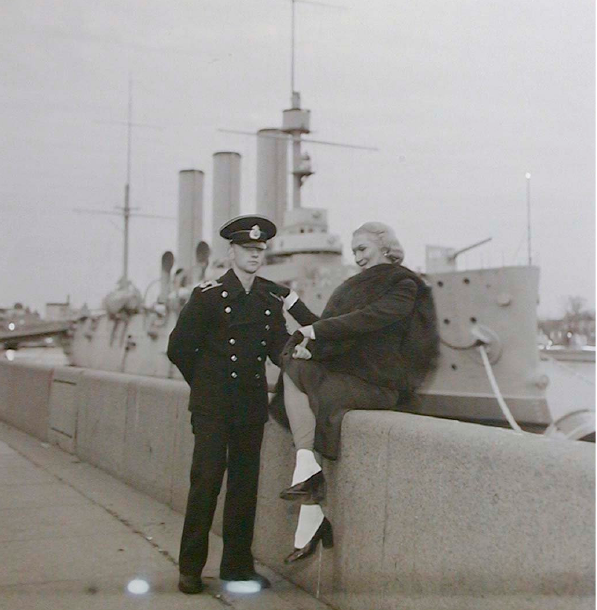
Figure 13. Vlad Mamyshev-Monroe. From the series “Happy Love (Liubov’ Orlova)” (2000);